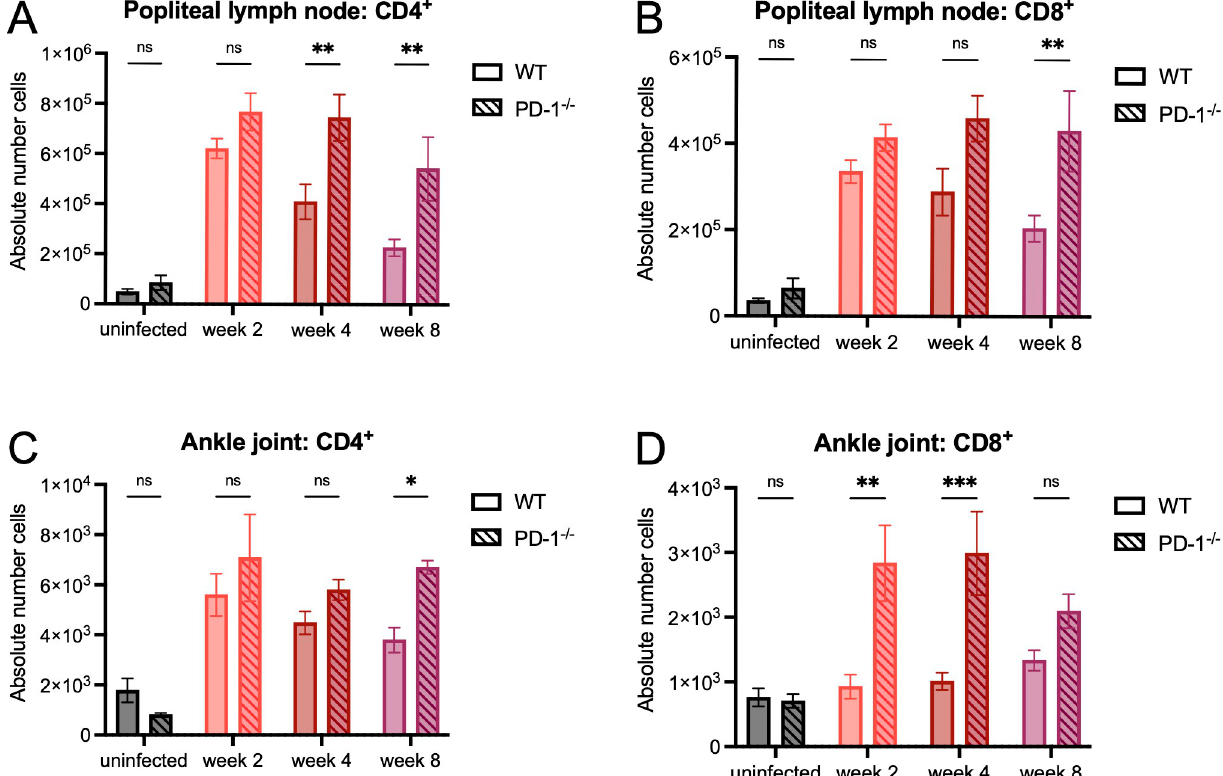
Fig 6. PD-1 prevents T cell accumulation during B . burgdorferi infection. WT and PD-1 -/- mice were inoculated with B . burgdorferi or media alone and sacrificed two, four, and eight weeks post-infection. Popliteal lymph nodes were assessed for accumulation of (A) CD4 + and (B) CD8 + T cells and ankle joints were assessed for accumulation of (C) CD4 + and (D) CD8 + T cells by flow cytometry through gating on live ➔ CD45 + CD3 + ➔ CD4 + or CD8 + cells. Data are pooled from four independent experiments with at least five mice per group and were analyzed using two-way ANOVA with Sidak’s multiple comparisons